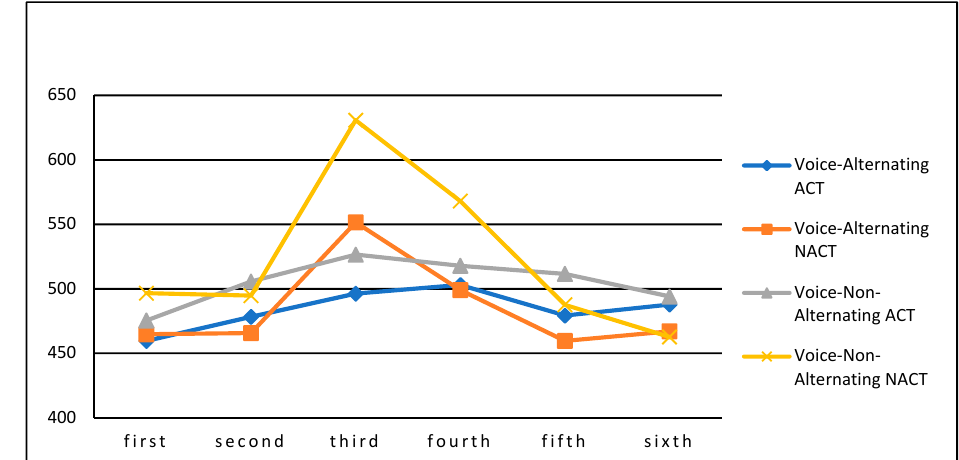
Figure 2. Verb class by voice morphological marking during sentence processing.